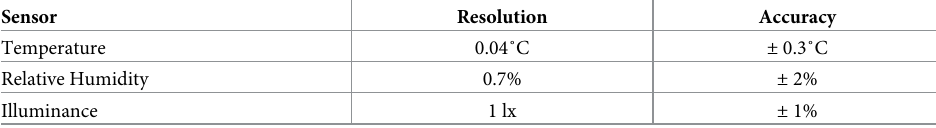
Table 2. Table of sensor characteristics. Resolution and accuracy of the sensors used for the monitoring